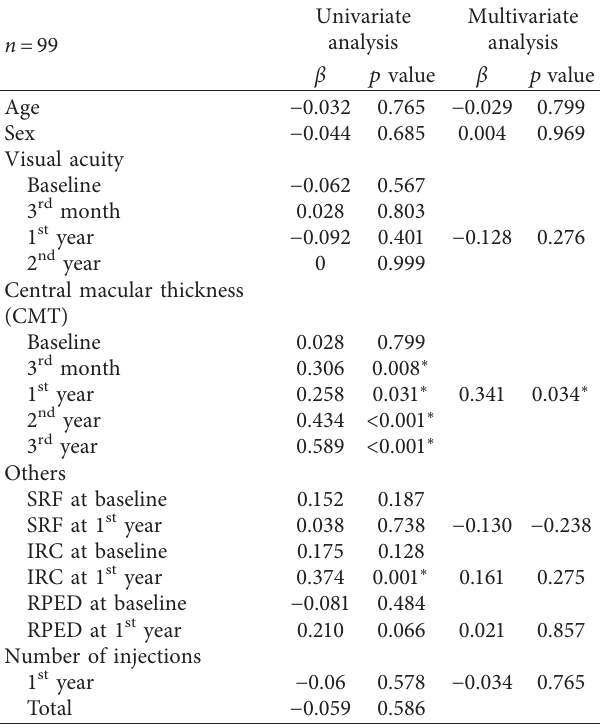
Table 2: Univariate and multivariate analysis for central macular thickness at the third year in the complete 3-year follow-up group ( n �